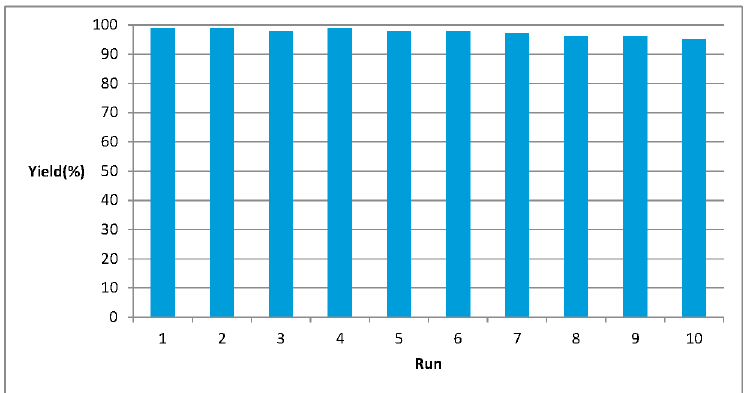
Figure 4. Recycling of the supported FeNP and the yield of isolated methylbenzoate in 10 subsequent runs. Reaction conditions: 2 mmol benzoic acid, 4 mmol MeOH, 7 mg FeNP@SBA-15 (0.2 mol. %) at reflux conditions for 6 h.